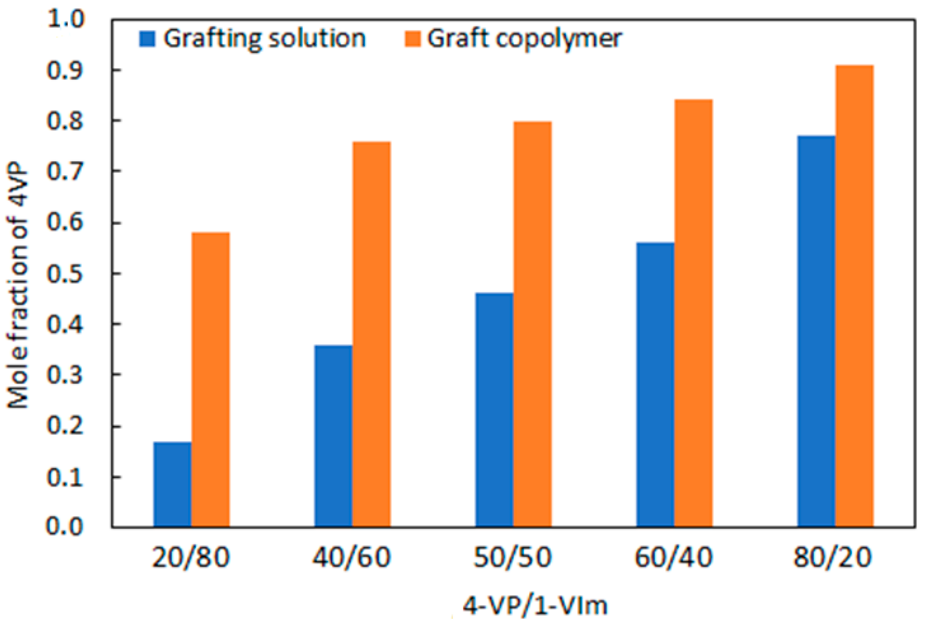
Figure 3. Variation of mole fraction of 4-VP in grafting mixture (blue) and in graft copolymer (orange). Grafting parameters: monomer conc. of 60 vol%, absorbed dose of 100 kGy, reaction time of 18 h, and temperature of 60 °C.